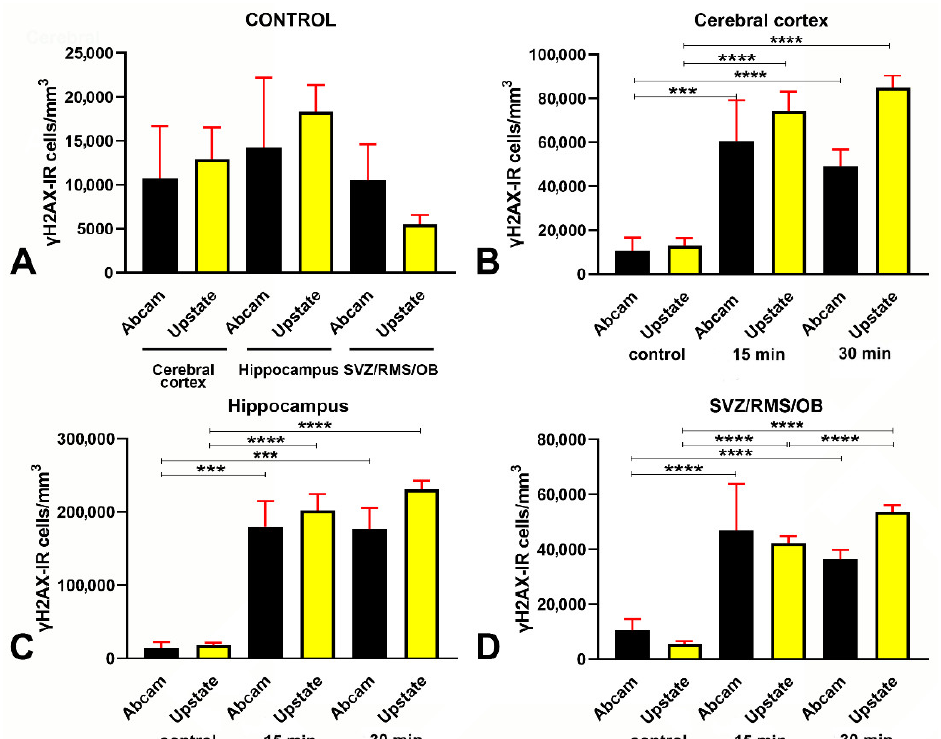
Figure 3. Volumetric density of γH2AX immunoreactive cells in control and irradiated mice after immunostaining with two different polyclonal rabbit antibodies. ( A ) Lack of statistically significant differences in the number of γH2AX immunoreactive cells/mm 3 after immunostaining with the Abcam or the Upstate primary antibody in control (nonirradiated) mice. ( B – D ) Statistically significant increase in the number of γH2AX immunoreactive cells/mm 3 in the cerebral cortex ( B ), hippocampus ( C ), and SVZ/RMS/OB ( D ) following X-ray irradiation. Trends are fully comparable after immunostaining with both primary antibodies. Data are expressed as mean ± 95% CI. *** 0.001 > p ≥ 0.0001, **** p < 0.0001. Bars are 95% CI. Numbers of statistical data are reported in Appendix E.